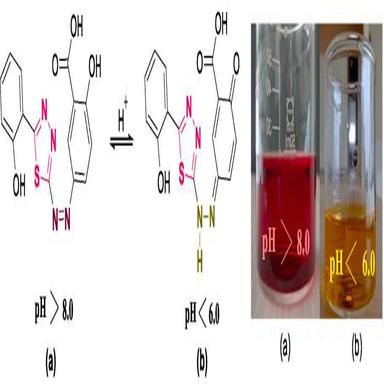
The color change of dye (1b) from red (a) to yellow (b) due to dye protonation.